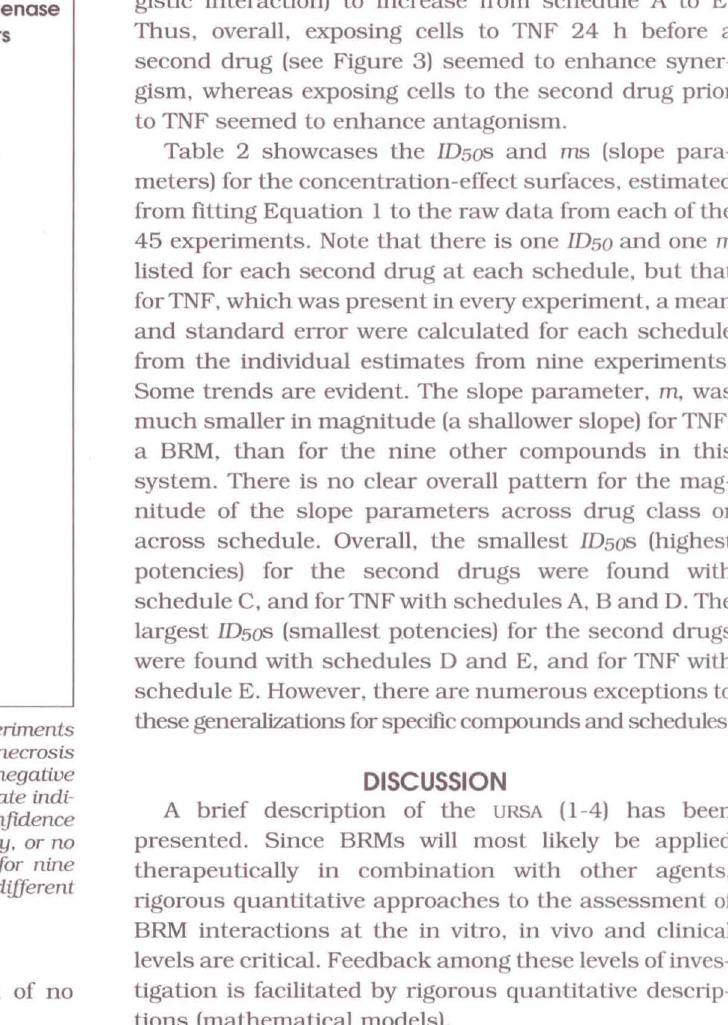
Figure 6) Alpha estimates for 45 growth inhibition experiments in which a second drug was applied along with tumour necrosis factor to L929 cells. A positive a. indicates synergism; a negative a. indicates antagonism. The bars around each a. estimate indi cate the 95% confuience intervaL When the 95% co'1fi.dence interval encompasses 0. then a conclusion of additivity, or no interaction, cannot be firmly discarded. The results for nine drugs, .from three classes, combined with TNF (with five